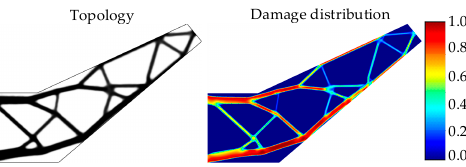
Figure 11. Optimal topology and damage distribution for an antenna bracket under multiple